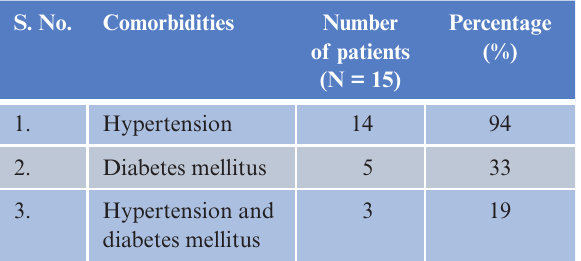
Table 1: Comorbidities in renal transplant recipients with COVID 19.